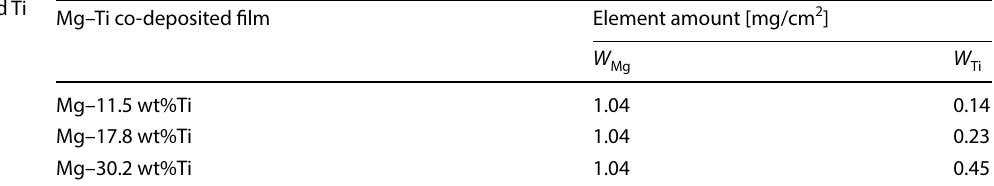
Mg–Ti co-deposited film